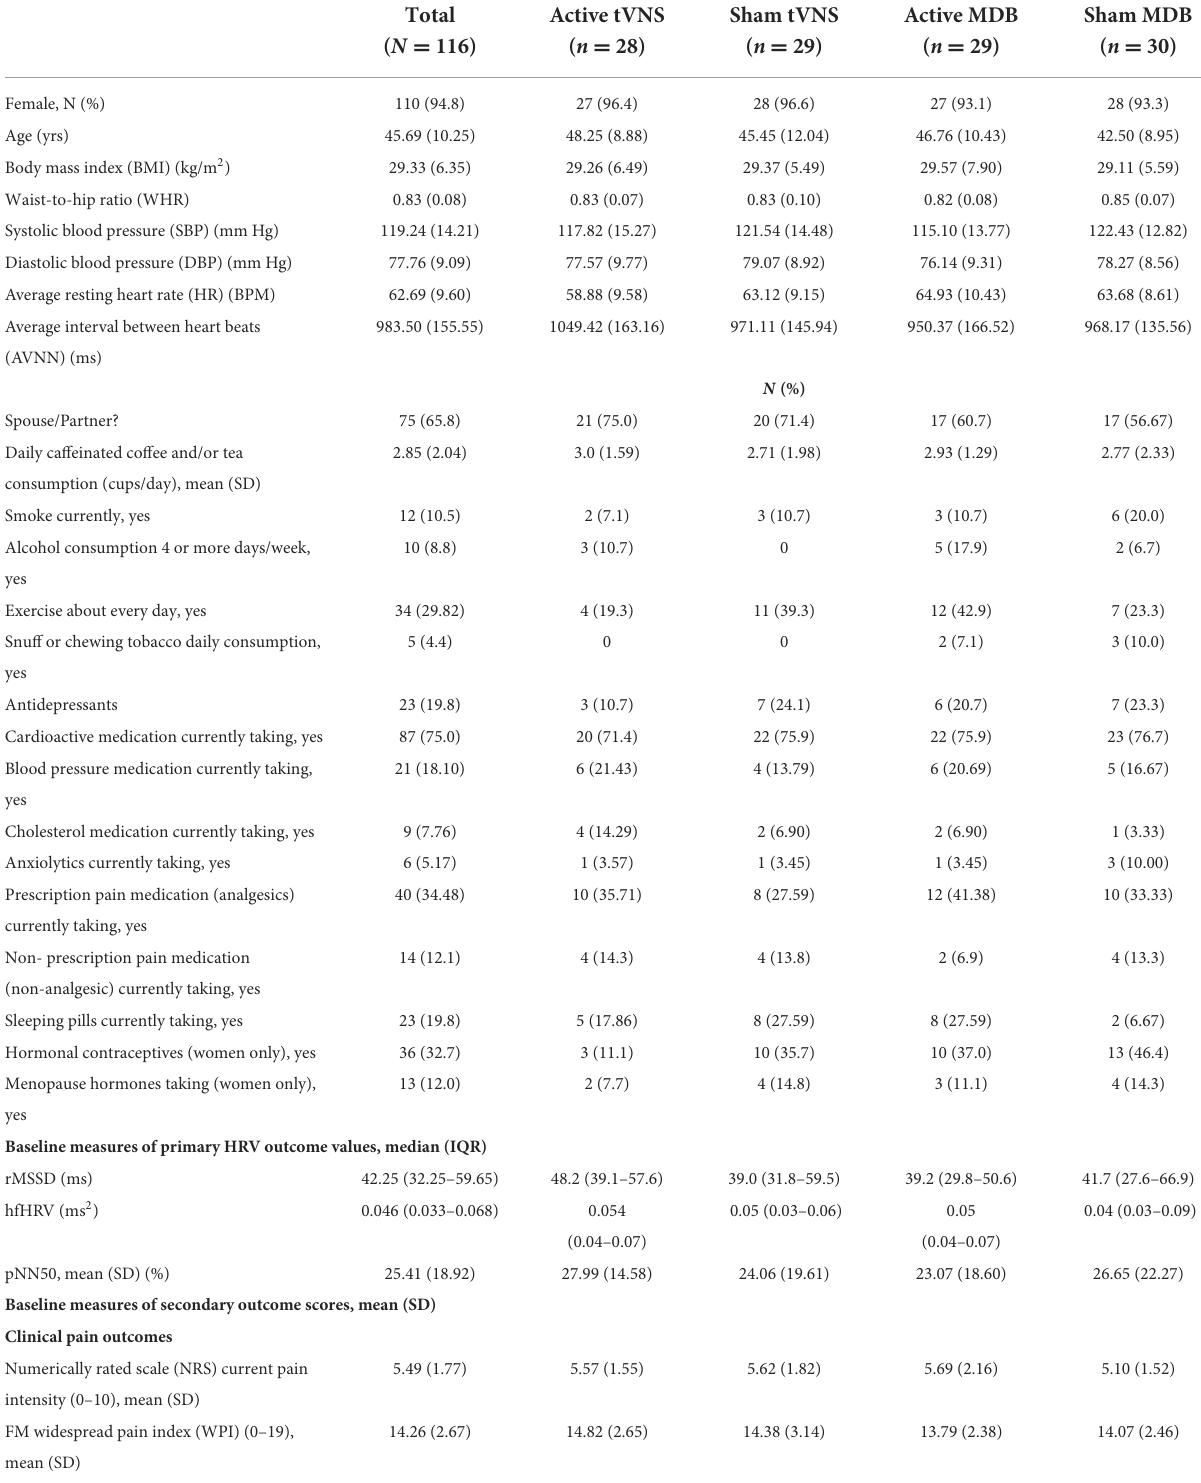
TABLE 1 Baseline characteristics of participants by treatment